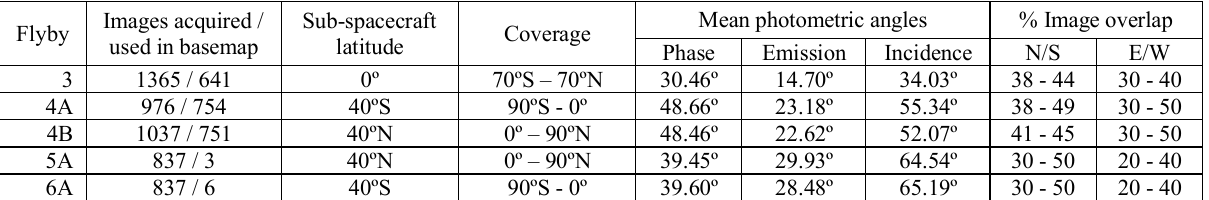
Table 2. Summary of imaging flybys for the global panchromatic basemap (after Bennett et al., 2020). Flyby